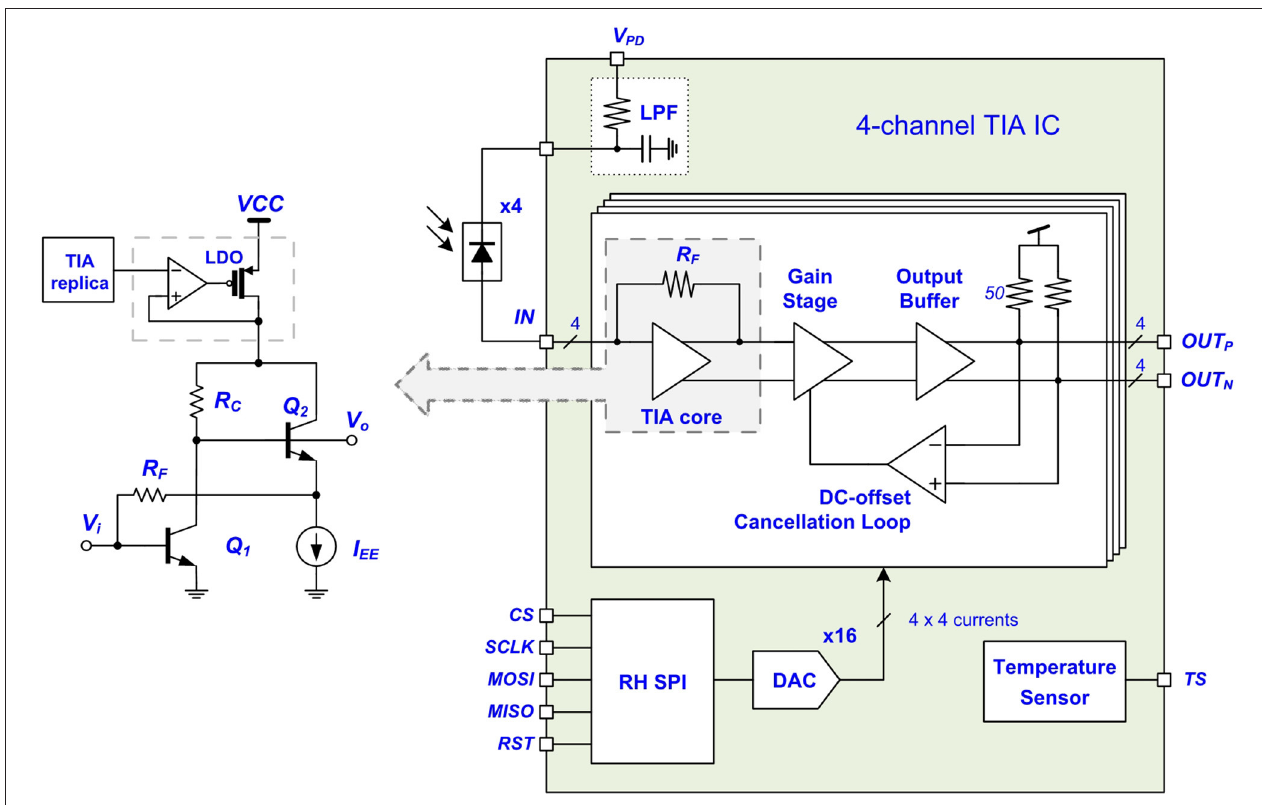
FIGURE 12 | TIA IC block diagram and TIA core